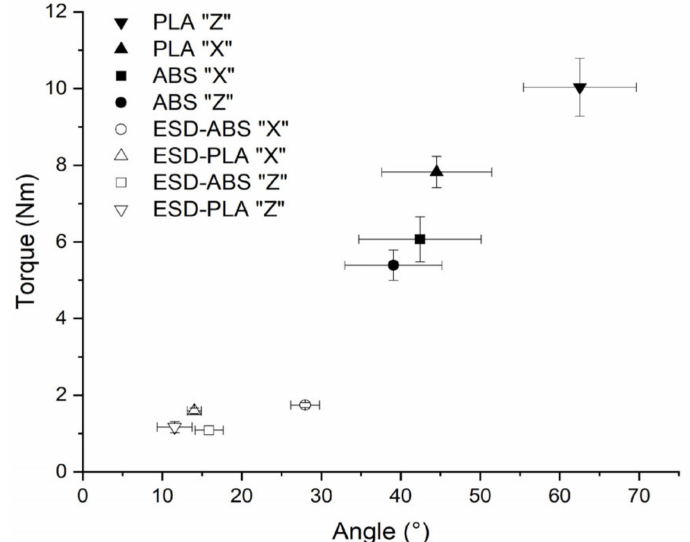
Figure 5. The results of torque strength tests and torsion angle of the test specimens manufactured with di ff erent materials. Mean values are demonstrated with the standard